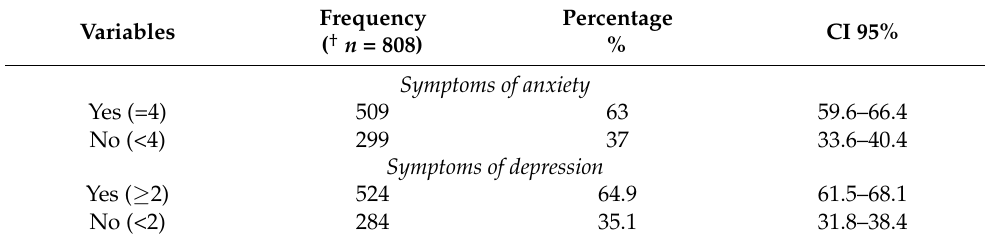
Table 3. Prevalence of anxiety and depression symptoms according to GADS * ( N = 808), Spain, 2020.